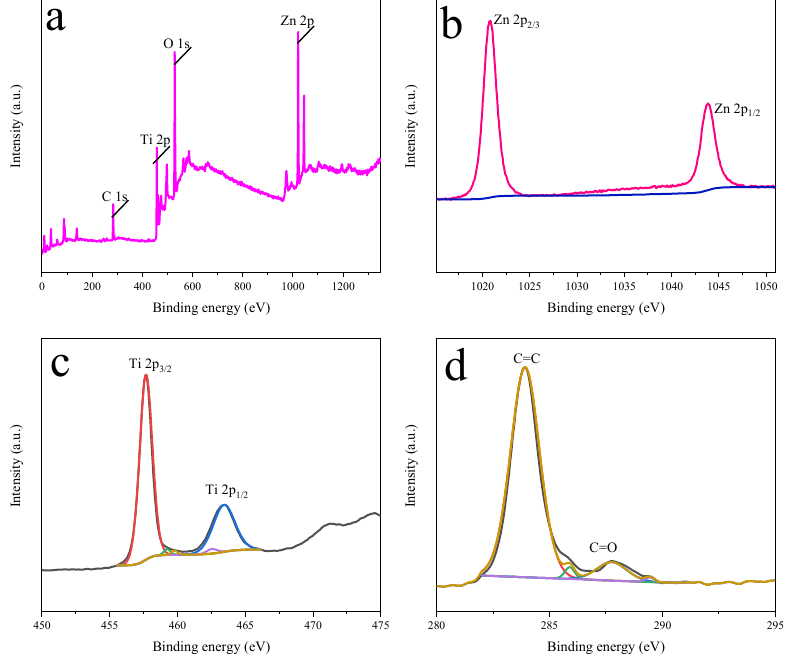
Figure 6. ( a ) Measured spectrum of ZnO-TiO 2 -rGO. ( b ) XPS spectrum of Zn. ( c ) XPS spectrum of Ti. ( d ) XPS spectrum of C.